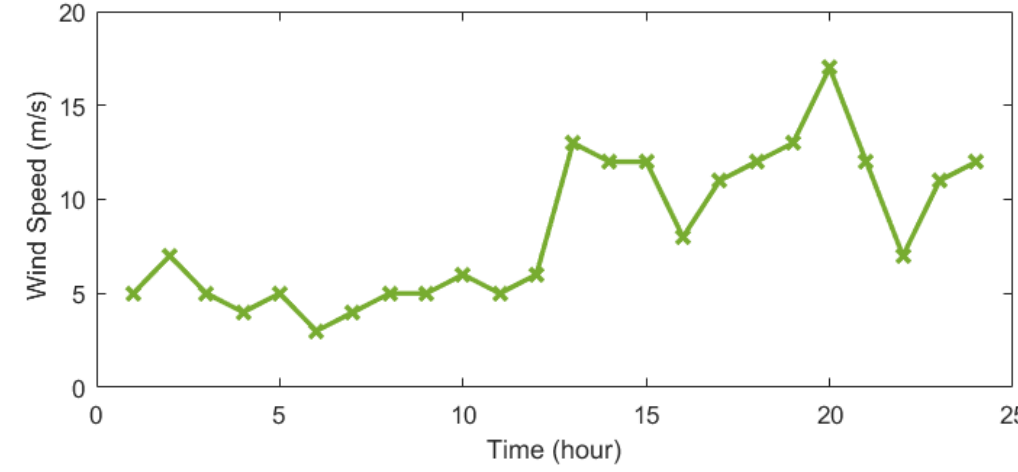
Figure 4. Profile of wind speed during a day.